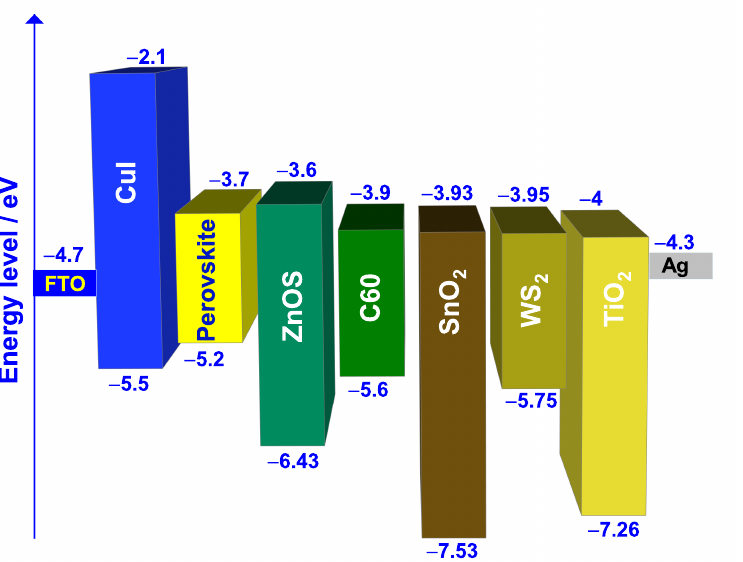
Figure 8. Band alignment between ETL materials and E1G20